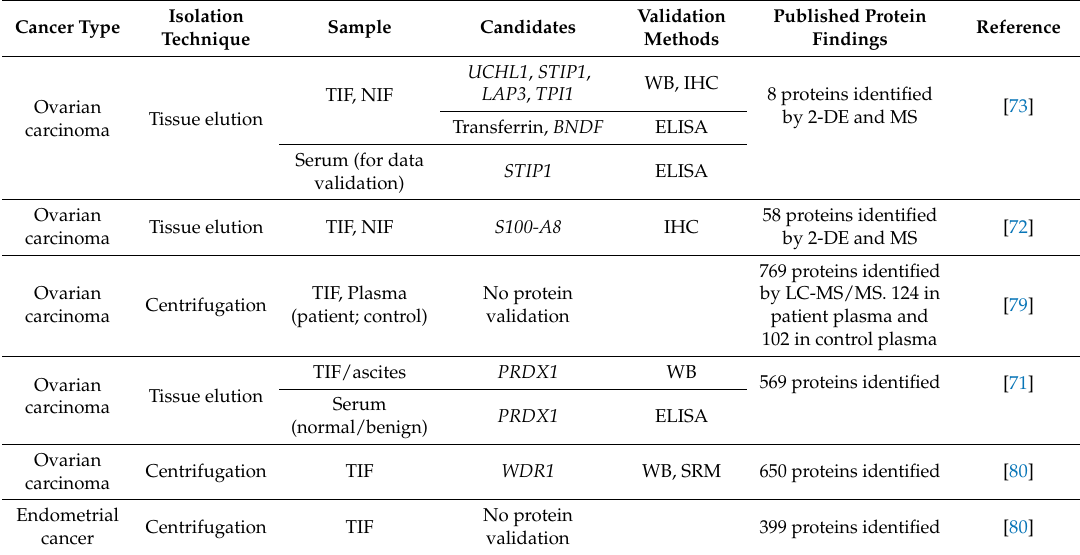
Table 1. Summary of proteomic studies in gynecologic cancer, including clinical biomarker candidates chosen for